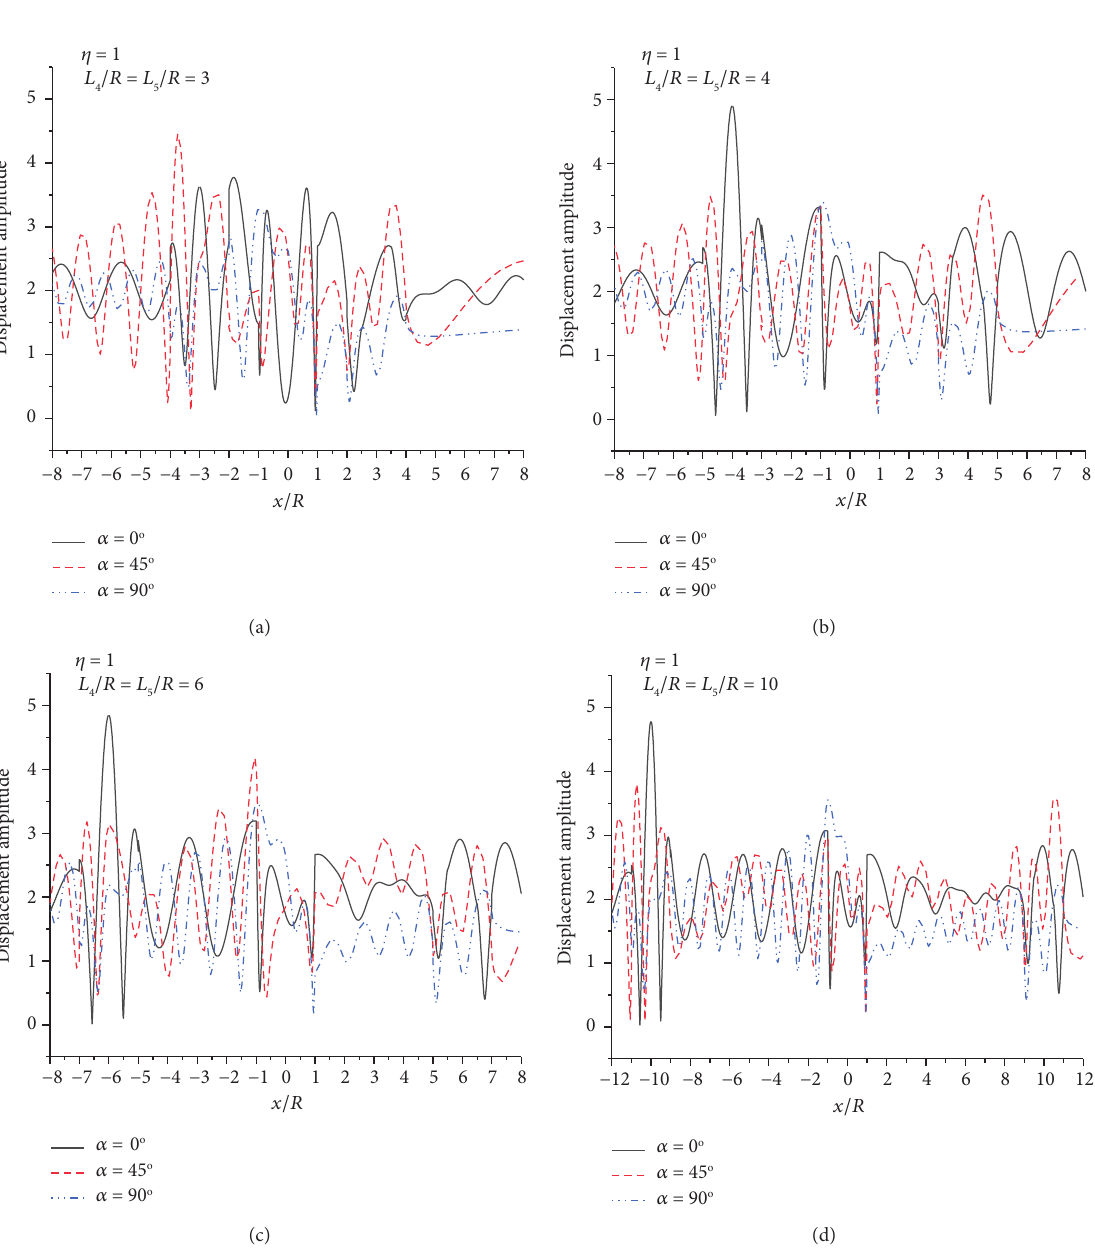
� L � 3. (b) Surface 4 5